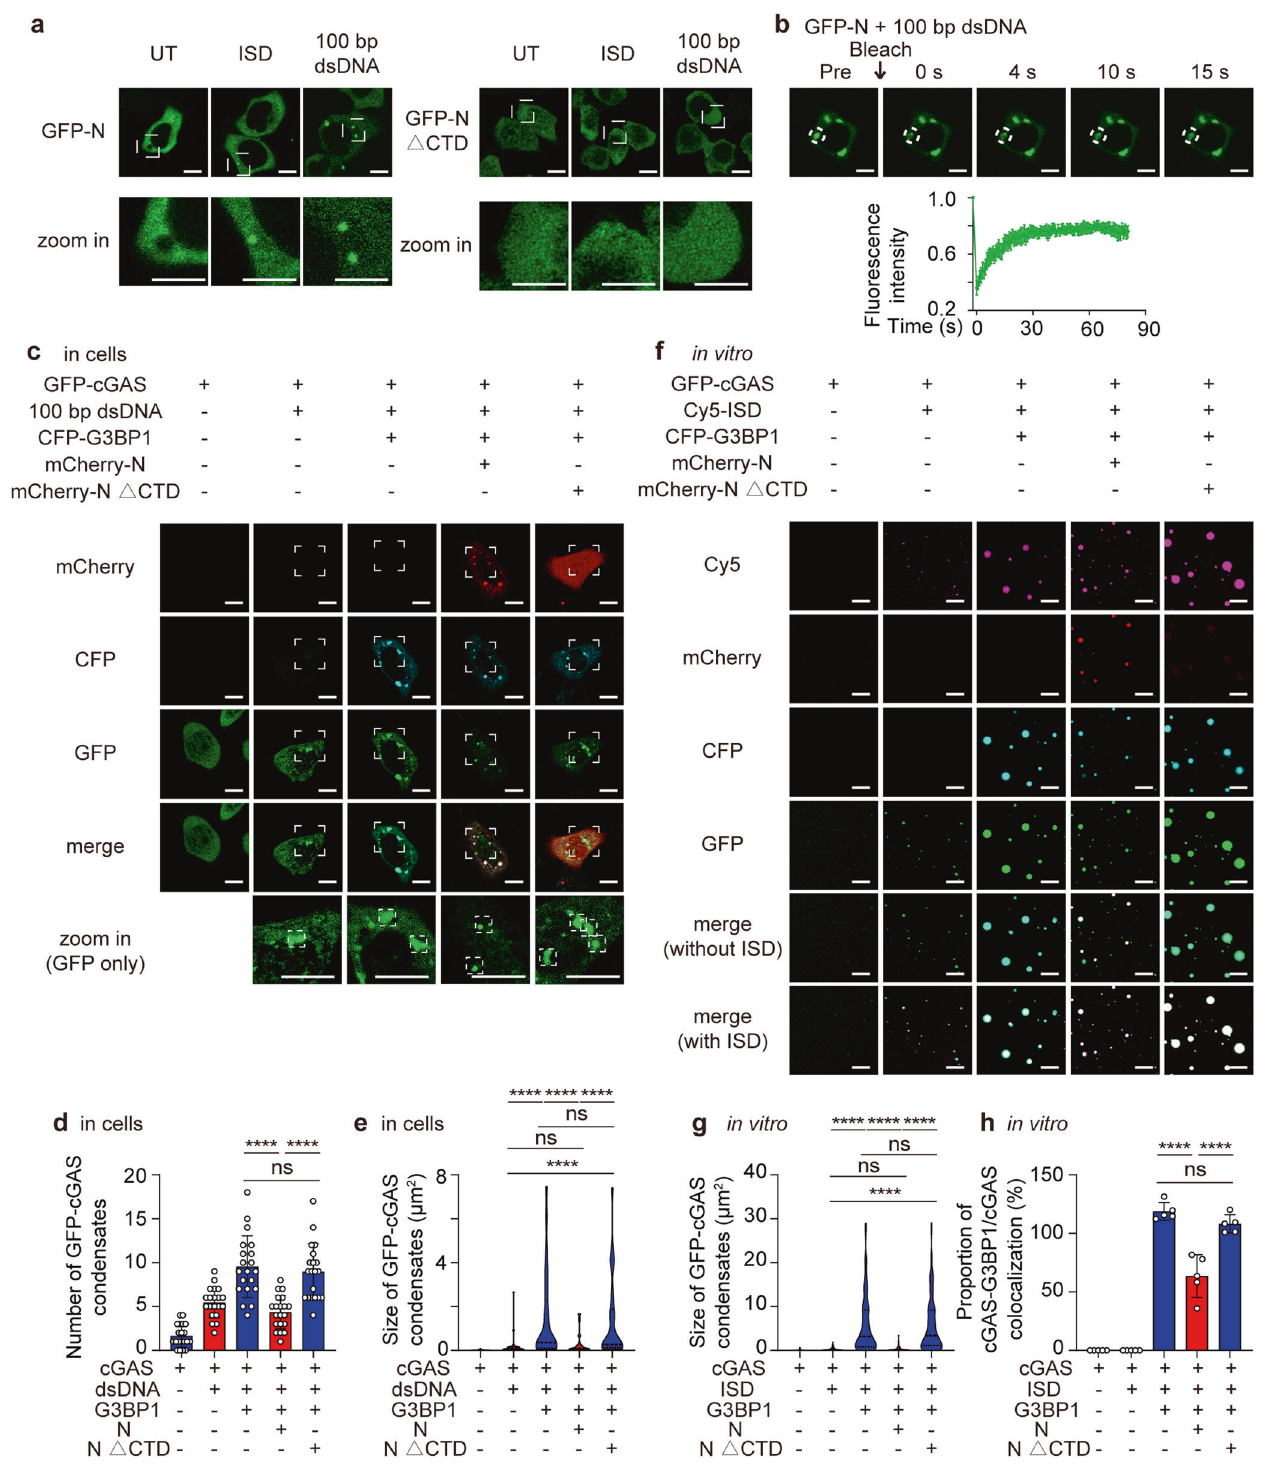
G3BP1, cytosolic DNA activates cGAS to form the LLPS condensates and facilitates the activation of IFN-I signaling. As counteractions, cytosolic DNA induces N protein LLPS and competitively binds with G3BP1 to disrupt the interaction as well as LLPS condensation between cGAS and G3BP1, conse- quently suppressing the cytosolic DNA recognition of cGAS as well as cGAS-mediated induction of IFN-I antiviral responses